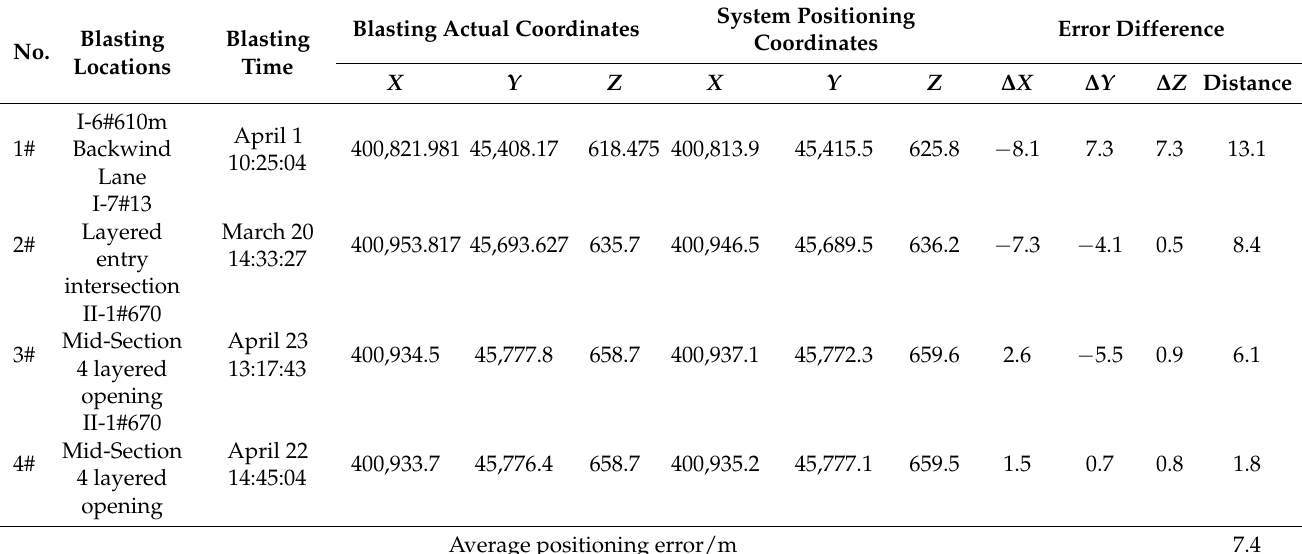
Table 1. Calibration of blasting information and positioning